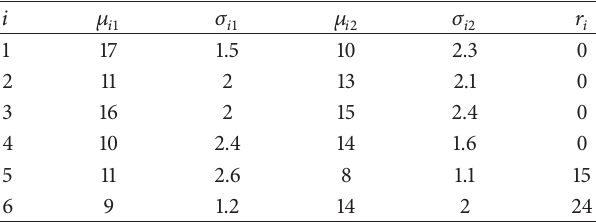
Table 1: Specifications of jobs. Table 2: Differences between 𝐸[ min {𝑡 𝑖1 , 𝑡 𝑗2 }] and 𝐸[ min {𝑡 𝑖2 ,𝑡 𝑗1 }] .